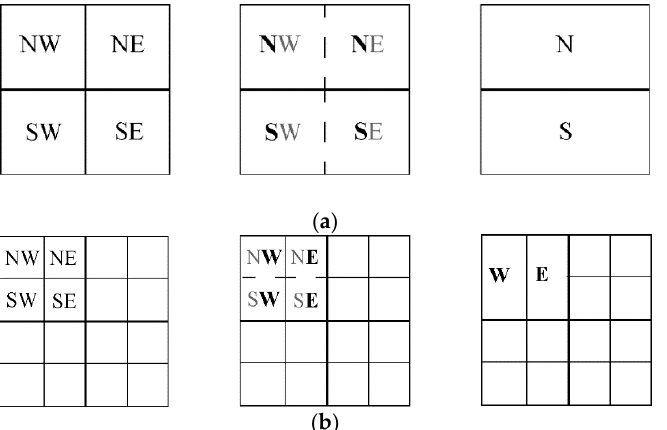
Figure 6. ( a ) Quarter sections are merged together to form northern and southern half sections. Removing the second string-character in the label field creates matching labels for two different Quarter Sections, northwest (NW) and northeast (NE), or southwest (SW) and southeast (SE). The Dissolve Tool uses these matching field values to combine quarter sections and generate the Half Sections. ( b ) The above illustrates how to generate east/west half-quarter sections, using the tech- nique of removing string characters from the label field, in this instance the first character is re- moved from the label field. A Dissolve combines features with matching labels.